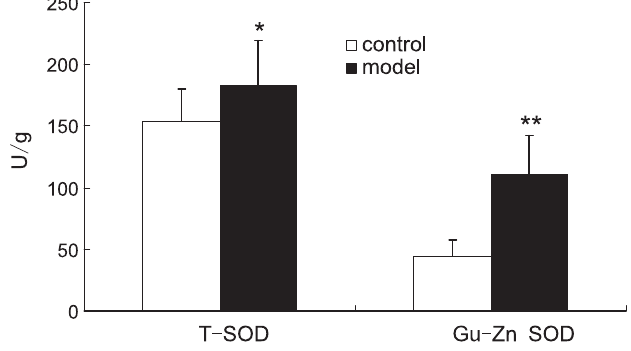
FIGURE 3 - Effects of hyperuricemia on T-SOD and Gu,Zn-SOD activity in brain in 4 th week. Data are mean ±SD, n =8. *P<0.05, **P<0.01 compared with control group